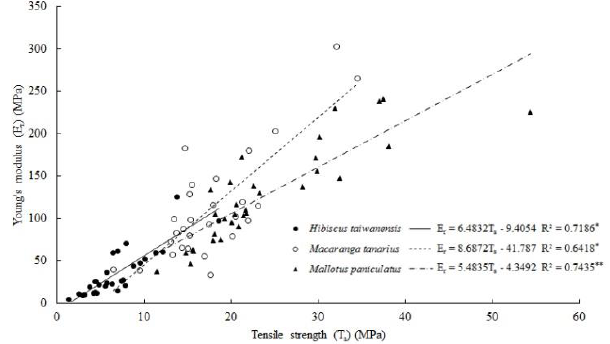
Figure 7. Relationship between Young’s modulus and root tensile strength for the three species studied.